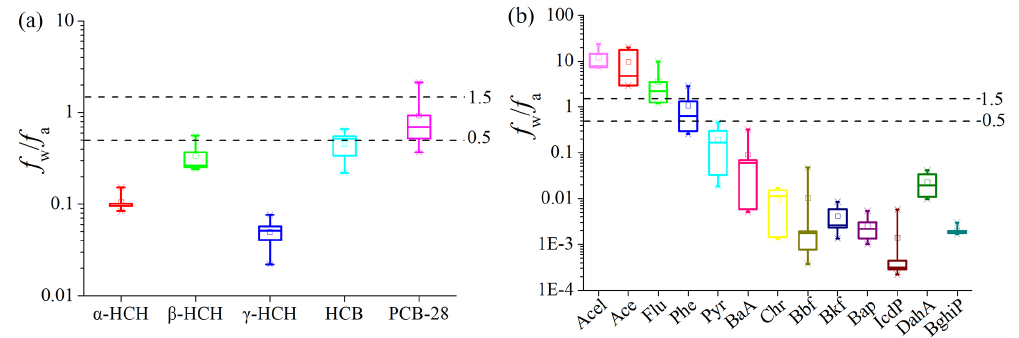
Figure 6. Water/air fugacity ratios ( f w /f a ) for OCPs and PCB 28 (a) , and individual PAHs (b) in Nam Co lake. The horizontal lines represent the uncertainty range, 0.5–1.5 was considered to be at